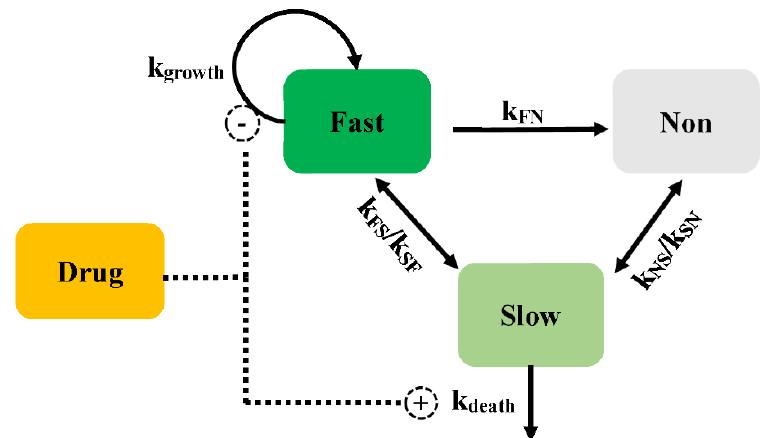
Figure 6. Schematic illustration of persistent resistance (Model 4).